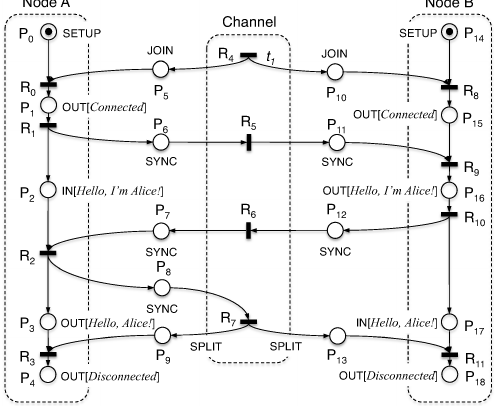
Figure 2: T-Net modeling example from Figure 1. R2. Reproducibility To allow for proper program